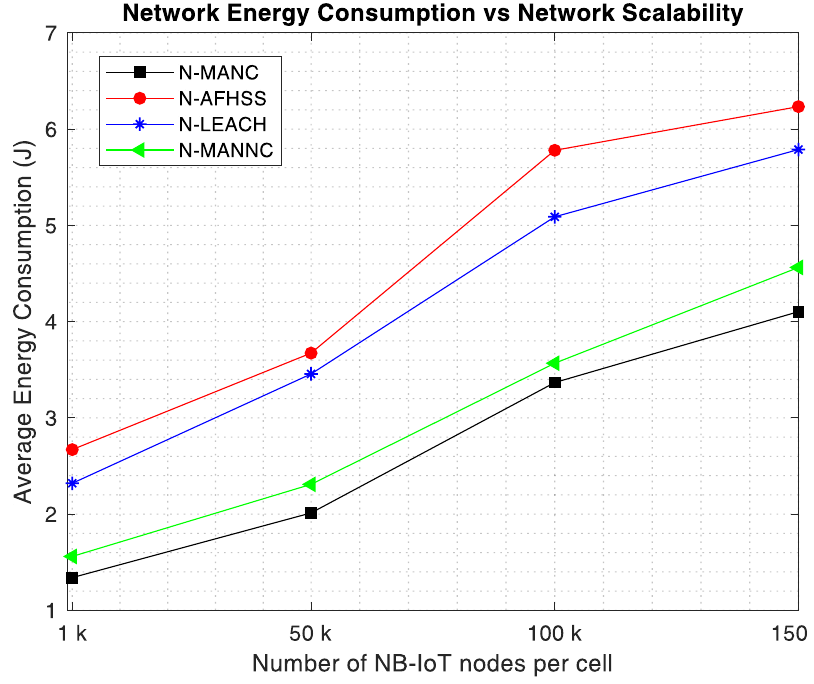
Figure 4. Average energy consumption versus network